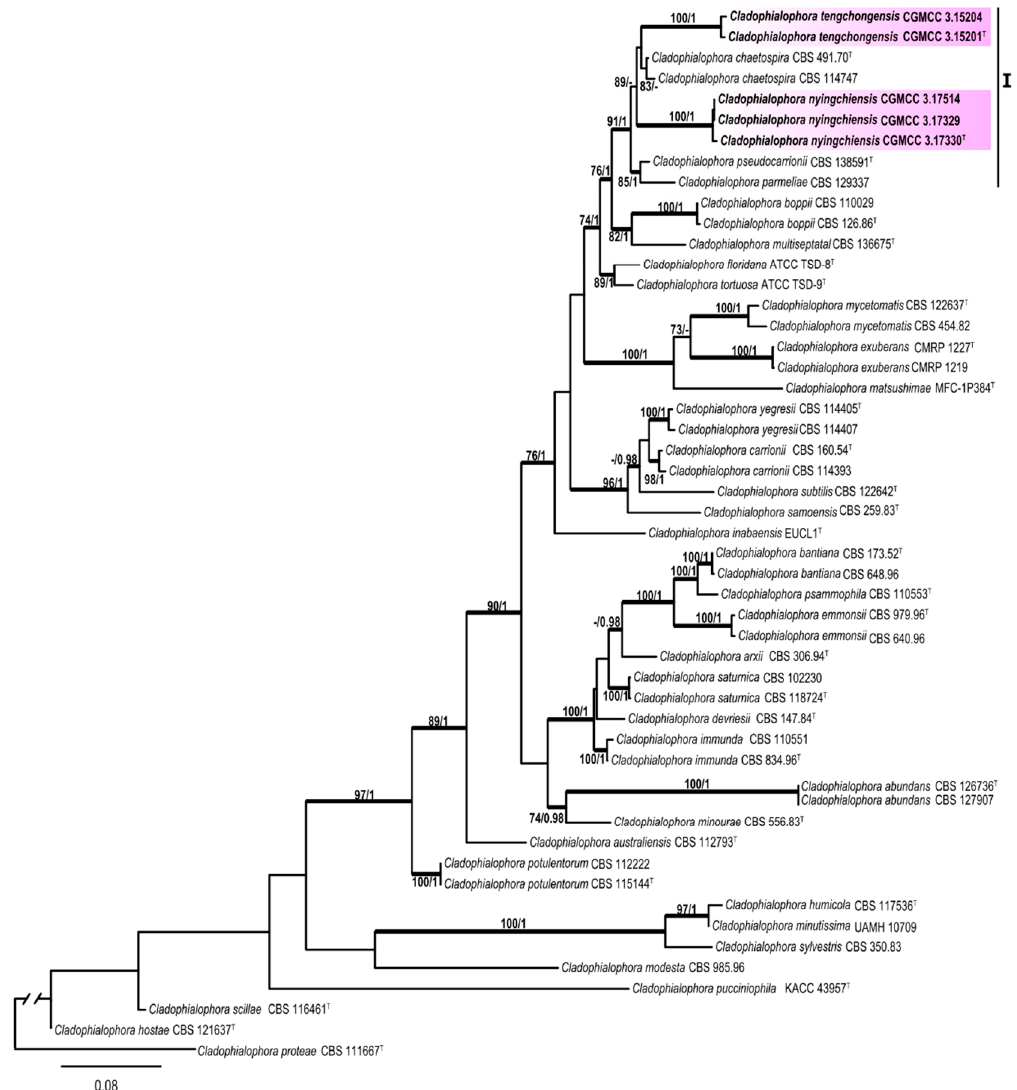
Figure 4. Phylogenic tree generated by the maximum likelihood analysis using combined sequences of ITS, small subunit of nuclear ribosomal RNA gene (SSU), translation elongation factor (TEF), TUB, and nucLSU loci of the genus Cladophialophora . Bootstrap values ≥ 70% ( left ) and Bayesian posterior probability values ≥ 0.95 (right ) are indicated at nodes (ML / BI). Thickened branches represent posterior probabilities ( > 0.95) from BI. Novel sequences generated in this study are indicated in bold. Cladophialophora proteae strain CBS 111667 is used as the outgroup. Ex-type cultures are marked with “ T ”.